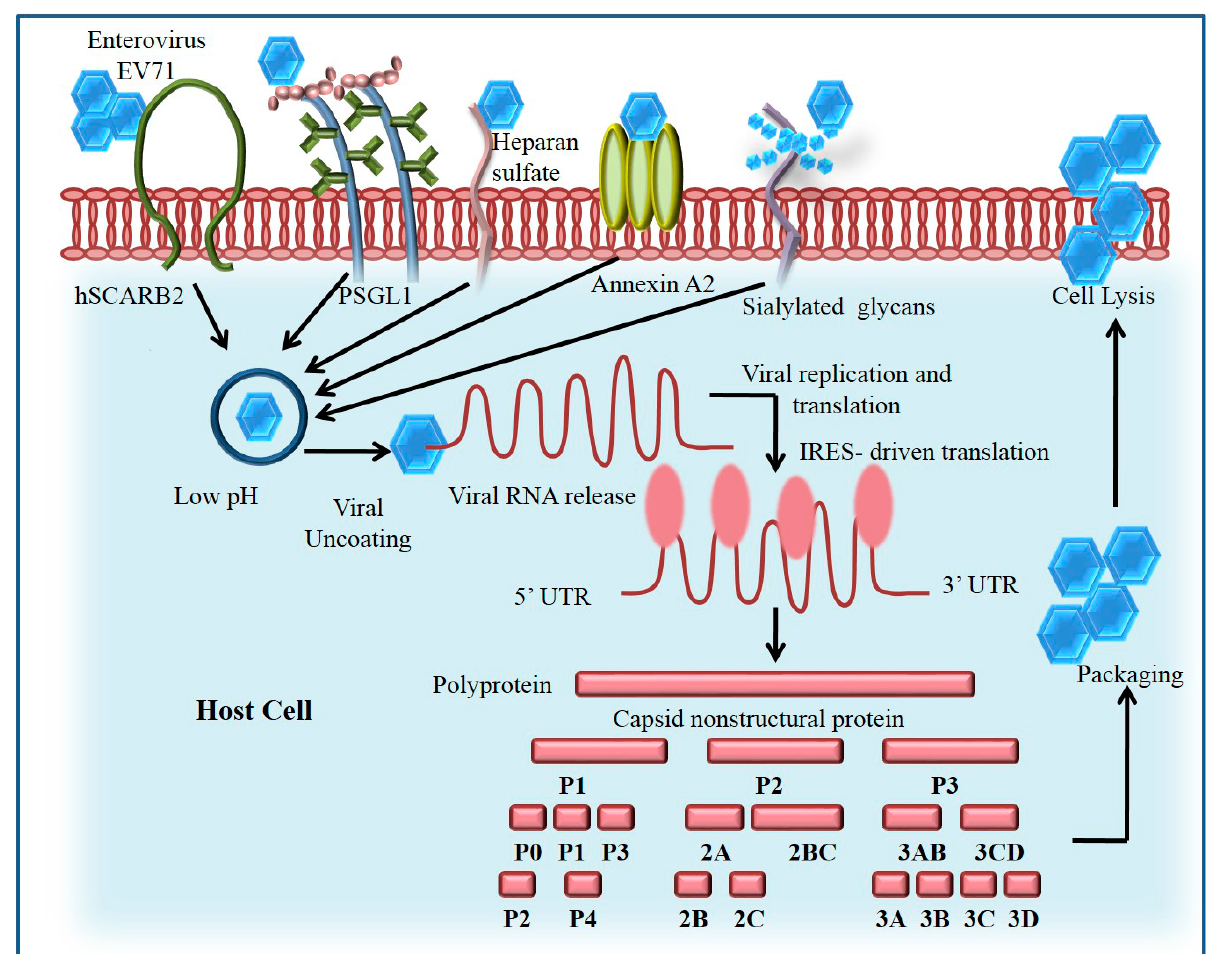
Figure 1. Invasion and replication of EV71 inside the host cell. EV71 attaches to cell surface receptors, co-receptors or other proteins. Endophilin binds to the cytoplasmic motif of activated receptors with SH3 domain and mediates the formation of endocytic carrier with actin polymerization and dynamin. The mechanism of immunogenic evasion of EV71 is based on the conformational changes in the antigen structure. A single polyprotein is produced by IRES-driven translation which is then cleaved into proteins by proteolysis.